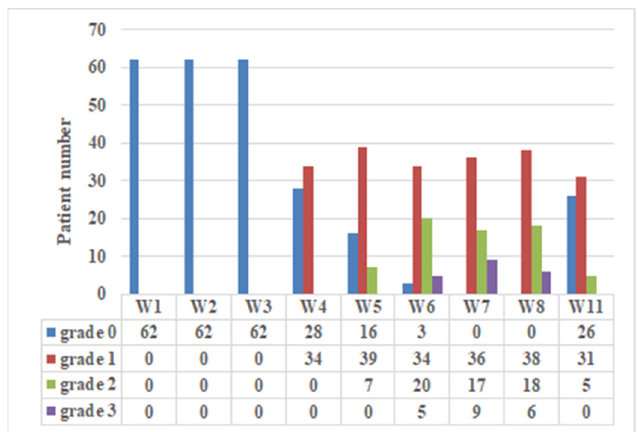
Figure 1. Incidence and severity of acute radiation dermatitis (ARD). The ARD of 62 NPC patients treated with IMPT was graded using CTCAE v. 4.0 reported weekly by physicians in a prospective fashion at treatment visits (1st to 7th weeks) and 1 week (8th week) and 1 month (11th week) after the completion of IMPT.